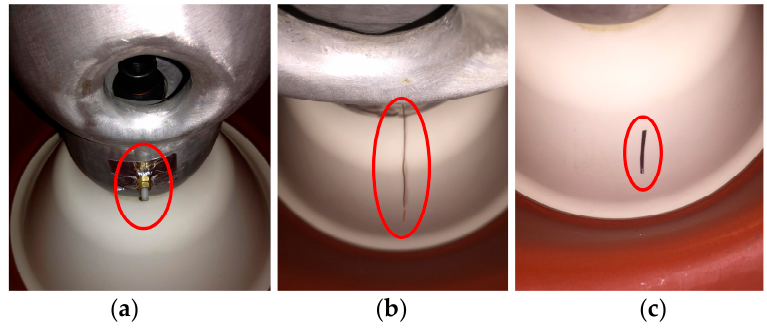
Figure 8. Typical PD defect patterns in actual 252 kV GIS tank: ( a ) floating electrode; ( b ) metal protrusion; and ( c ) particles on the spacer surface.